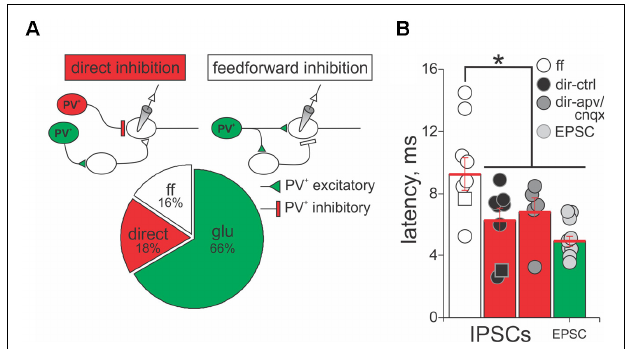
FIGURE 7 | PV + neurons form direct and feedforward inhibitory circuits in the SC. (A) Top panel, schematic diagrams of the PV + driven inhibitory circuits, direct and feedforward, found in our recordings. PV + , red circles; PV − , white circles. Triangles depict excitatory terminals and bars depict inhibitory terminals. Lower panel, percentage of recordings providing evidence for direct inhibition (18%), feedforward inhibition (16%), and excitatory (66%) circuits resulting from optogenetic activation of PV + neurons. (B) Latency of the peak outward currents classified as feedforward (ff, white circles), direct inhibition before (dir-ctrl, black circles), and after APV/CNQX application (dir-apv/cnqx, gray circles). The latency of the peak inward currents in neurons showing feedforward inhibition is also shown (EPSC, light gray circles). Red bar: mean ±